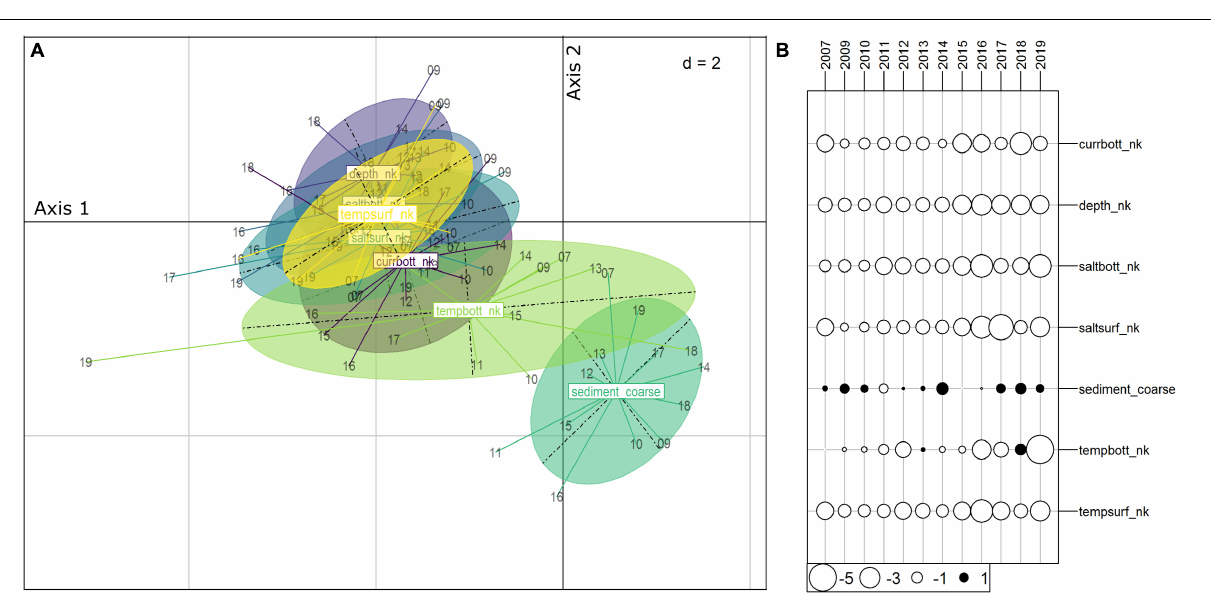
FIGURE 6 | Intrastructure analysis for fish: (A) The yearly average position of environmental variables in the space of the compromise is the center of the ellipses and each point is the yearly position (two last numbers of the year are printed), (B) score of the environmental variables on axis 1 of the